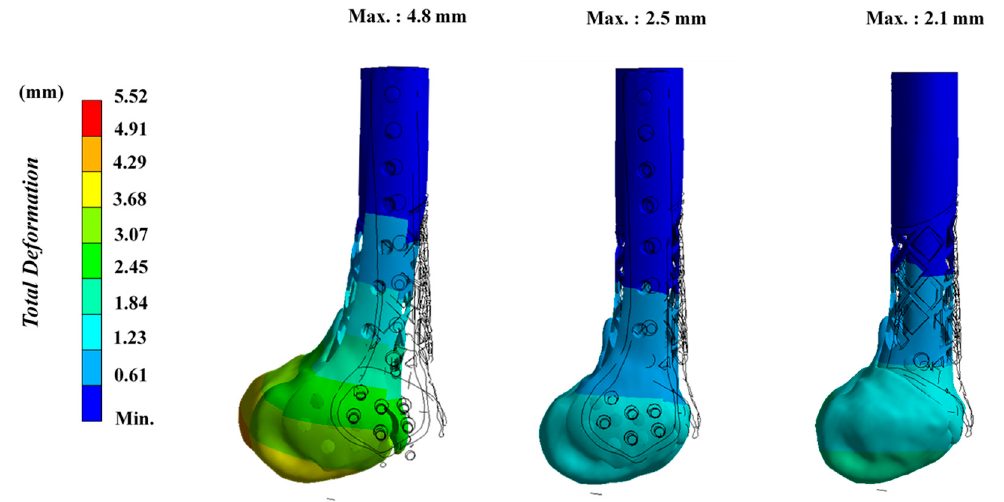
Figure 6. Overall displacement of the construct can be found at the distal condyle and was about 4.8 mm in the first stage. It was reduced to 2.5 mm with completion of osseointegration in the second stage and can be reduced to 2.1 mm after removing the locking plate in the third stage.